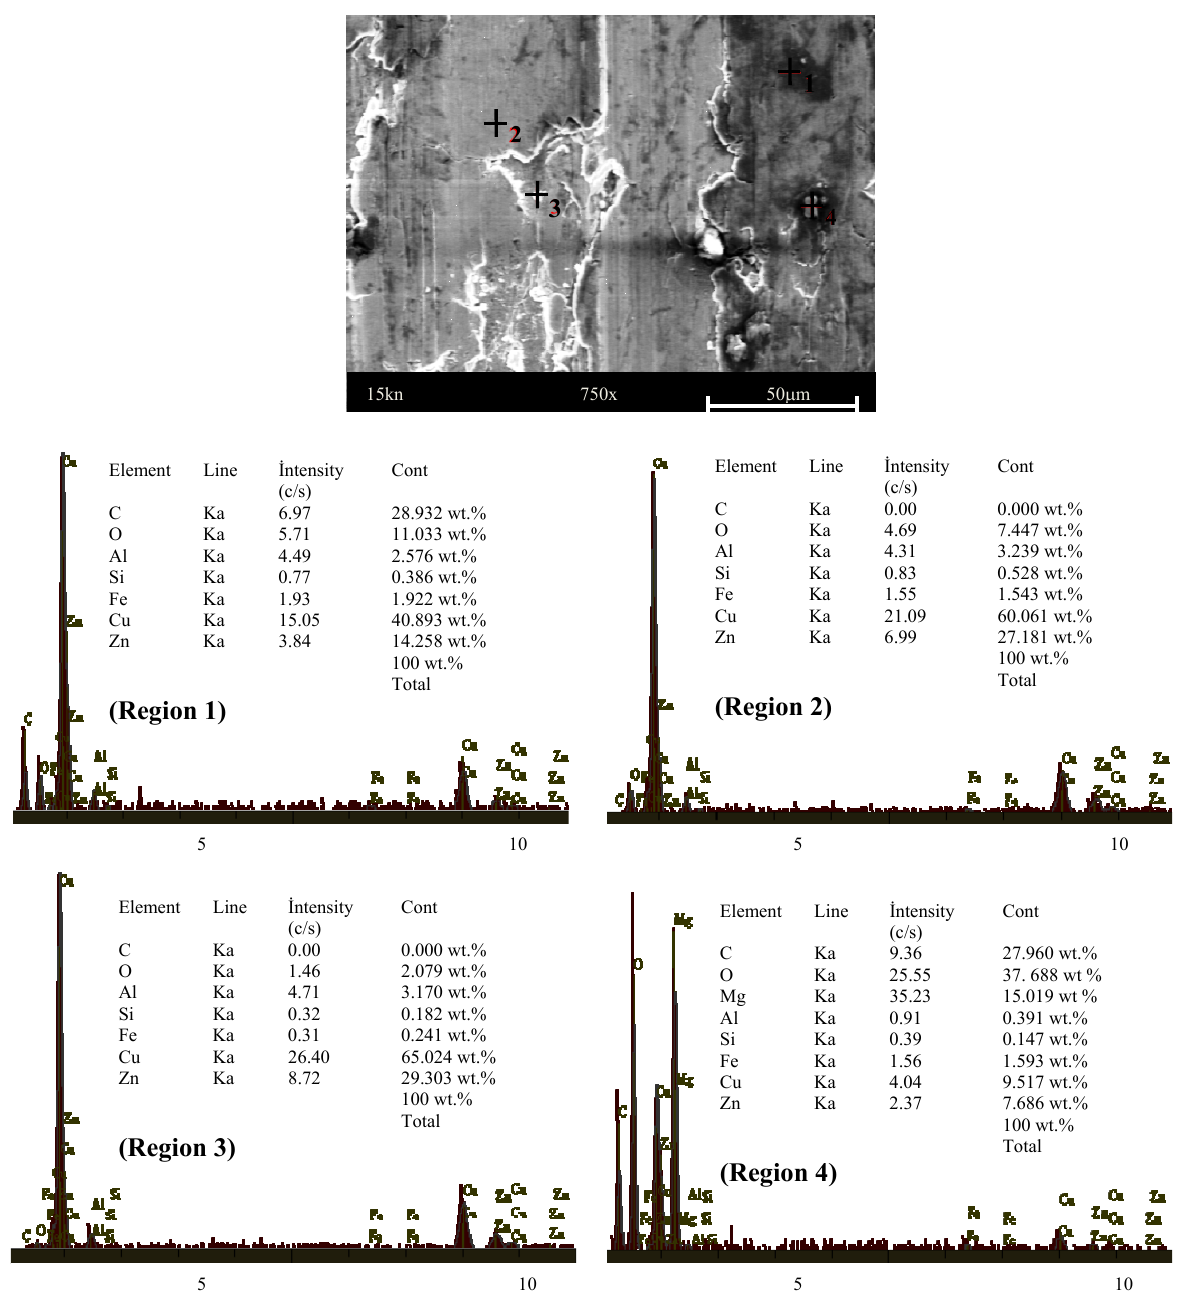
Figure 14. Worn surface SEM and EDAX analysis of centrically cast brass worn under loads of 40 N, at 0.4 m s (cid:3) 1 speed and against pearlitic ductile iron